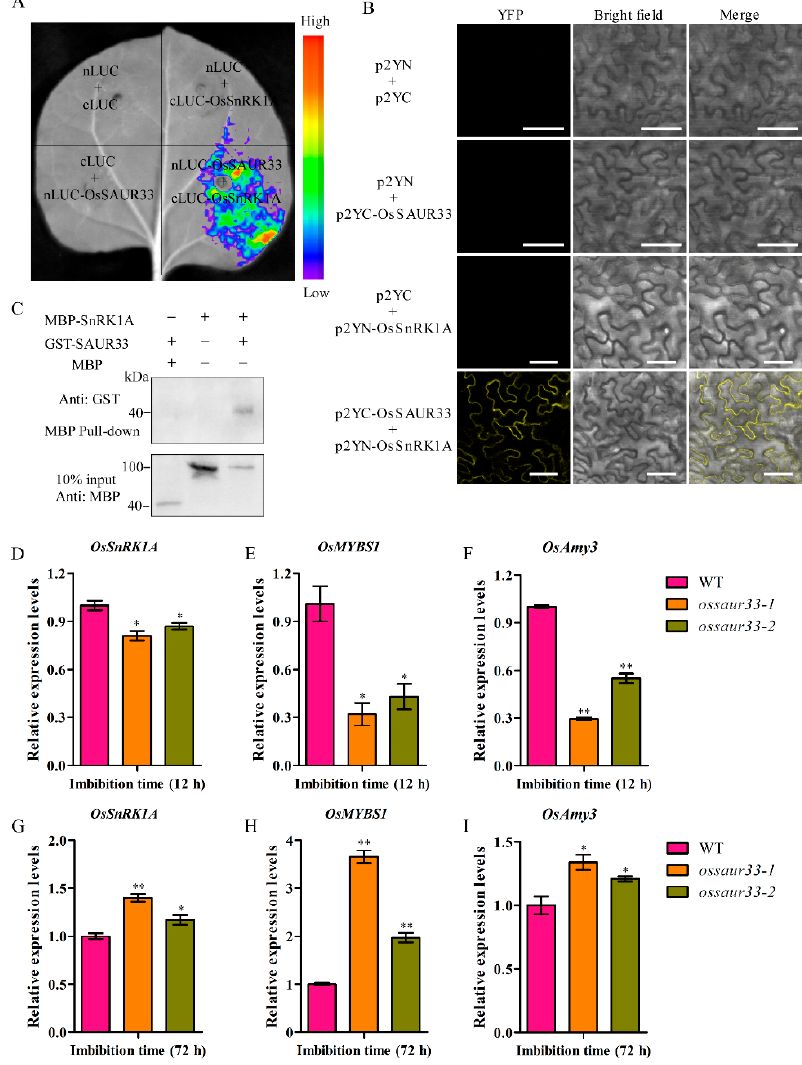
Figure 6. OsSAUR33 interacts with OsSnRK1A and alters the expression of OsSnRK1A , OsMYBS1 , and OsAmy3 during seed germination in rice. ( A ) Firefly luciferase (LUC) complementation imaging assay. nLUC-OsSnRK1A and cLUC-OsSAUR33 with the control vector were co-infiltrated into N. benthamiana leaves. LUC images were captured using a cooled Charge-coupled Device (CCD) imaging apparatus. ( B ) Bimolecular fluorescence complementation (BiFC) assay. OsSAUR33 and OsSnRK1A were fused to p2YC and p2YN, respectively. Different pairs of constructs were co-expressed in N. benthamiana . Yellow fluorescent protein (YFP) fluorescence was detected by confocal microscopy. Bar = 50 μ m. ( C ) Maltose Binding Protein (MPB) pull-down assay of the OsSAUR33 and OsSnRK1A interaction. Anti-GST antibody was used to detect the output protein. The expression of OsSnRK1A ( D , G ), OsMYBS1 ( E , H ), and OsAmy3 ( F , I ) in the WT and the ossaur33 mutants at 12 h and 72 h of imbibition. The expression of genes was normalized to that of OsActin . Each column represents the mean ± standard deviation, black small symbol means the value of each replication, n = 3.